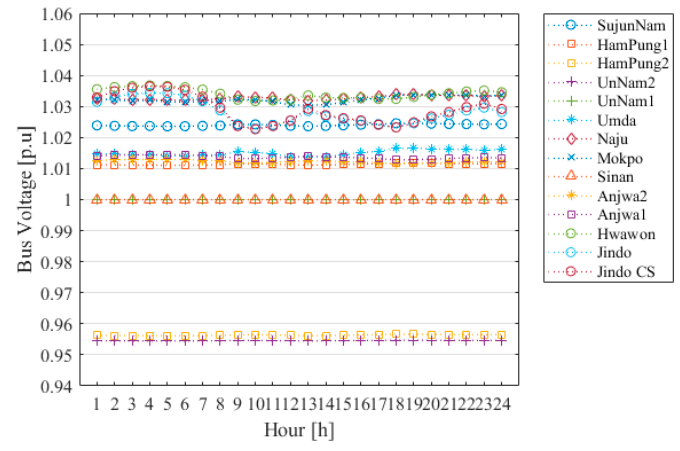
Figure A1. Voltage profile for case study of MVDC candidate #1.